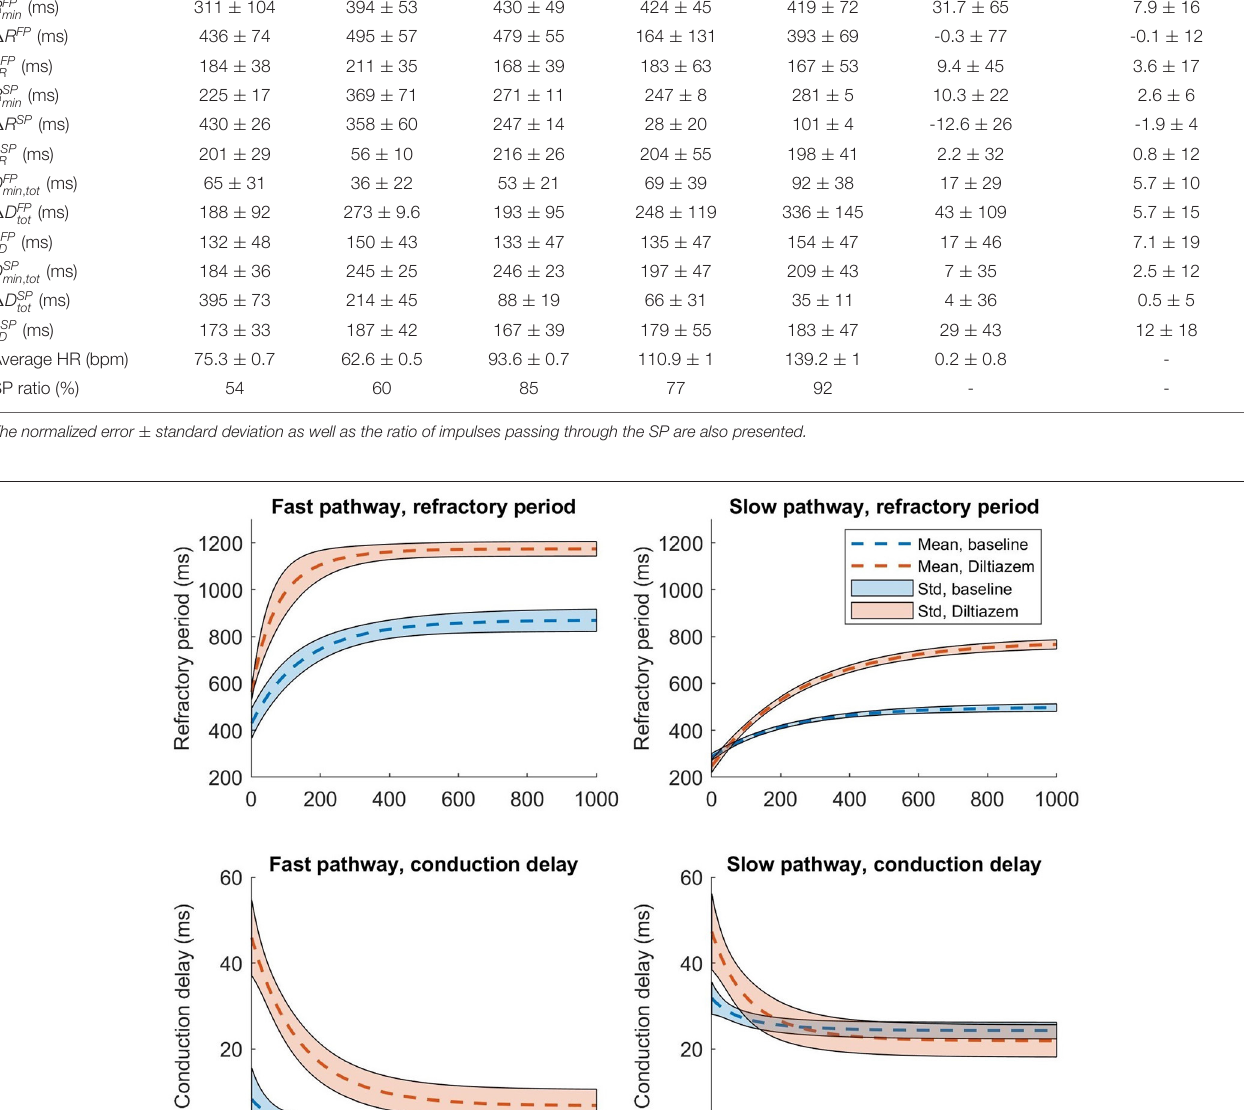
TABLE 2 | The mean parameter values deviation for each parameter. Parameter